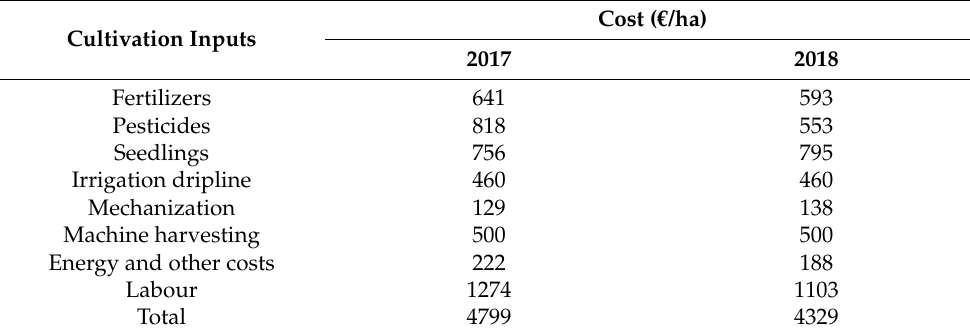
Table 1. Variable production costs, net of the variable component of irrigation costs. Cultivation Inputs